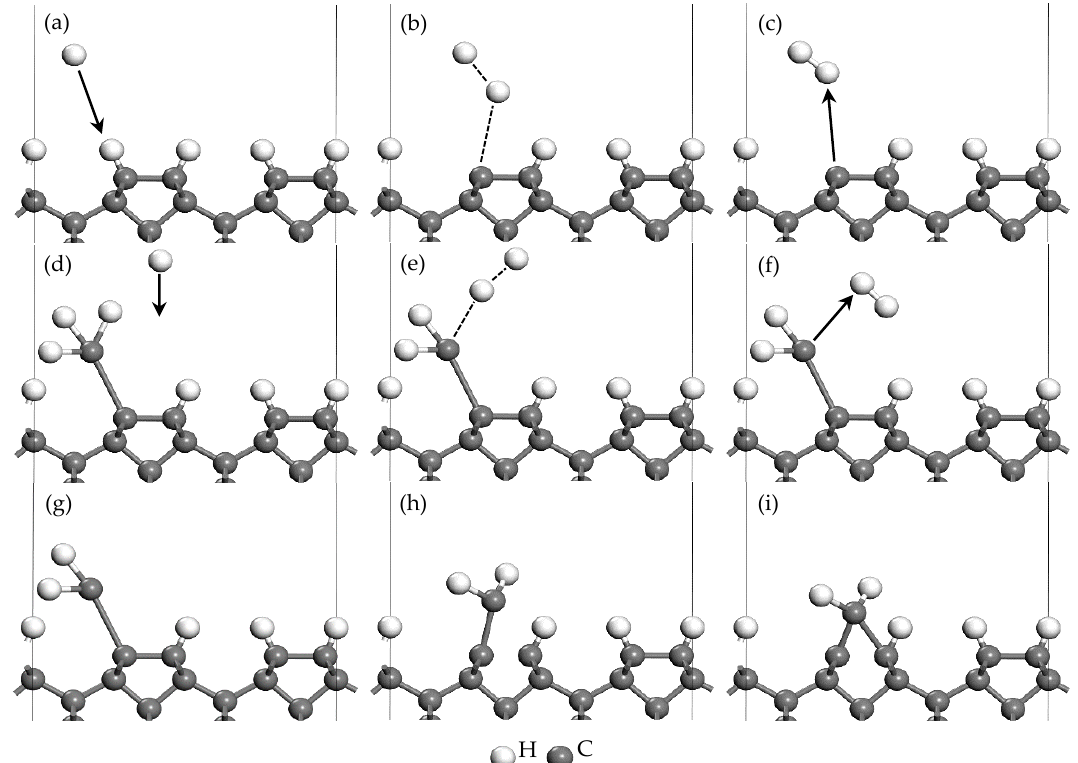
Figure 1. (Color online) ( a ) A hydrogen atom approaches the hydrogen-terminated C–C dimer of the diamond surface; ( b ) The terminated hydrogen atom is extracted from the transition state; ( c ) This forms a hydrogen molecule away from the diamond surface. ( d ) A methyl molecule is bonded to the diamond surface; ( e ) The hydrogen atom of this methyl molecule is extracted from the transition state; ( f ) This forms a methylene molecule on the diamond surface and a hydrogen molecule away from the diamond surface. ( g ) Finally, a methylene molecule approaches; ( h ) This methylene molecule causes the C–C dimer in the pentagon carbon ring to break; ( i ) This pentagon carbon ring becomes a hexagon carbon ring. White and gray spheres represent H and C atoms, respectively.